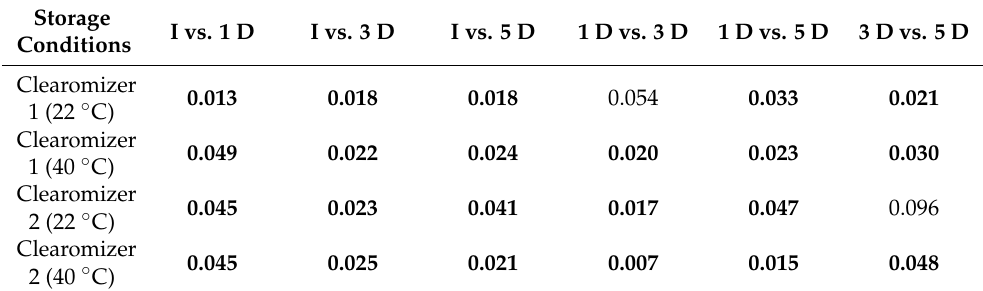
Table 6. The influence of the duration of storage on Ni concentration; p -value for the paired t -test ( t -test: Paired Two Sample for